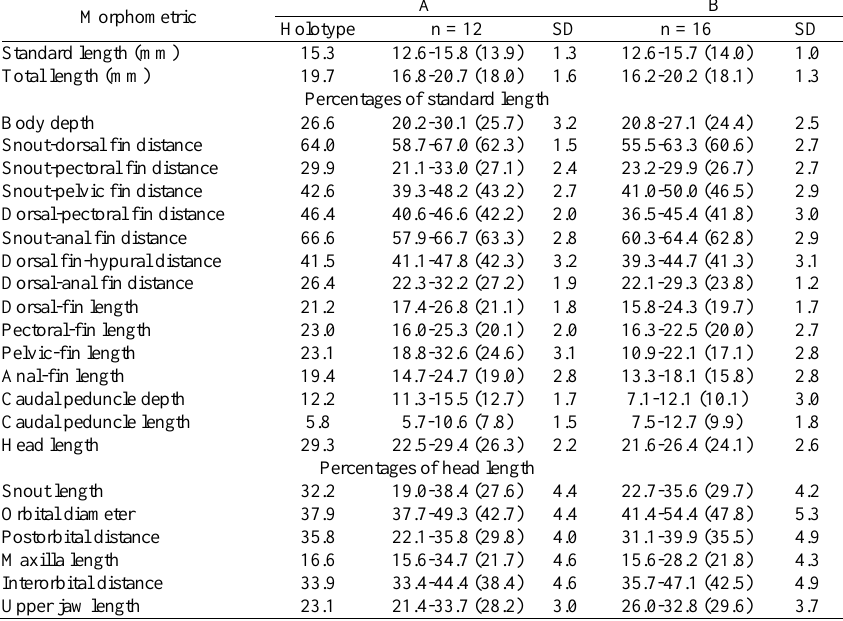
Table 1. Morphometric data of holotype (male) and paratypes (A, adult males including the holotype and B, adult females and juveniles) of Tyttocharax metae . Values in parentheses = mean. SD = Standard